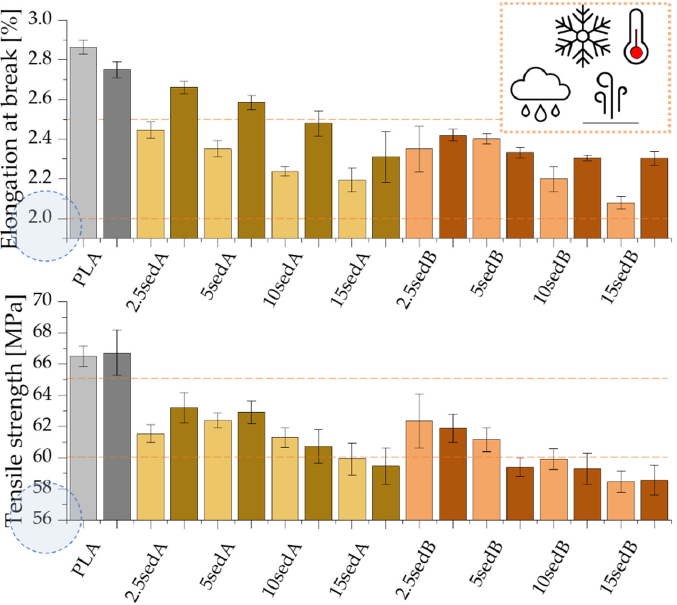
Figure 14. Tensile strength and elongation at break for the composites PLA/sedA-B after conditioning in the weathering chamber (WCh).